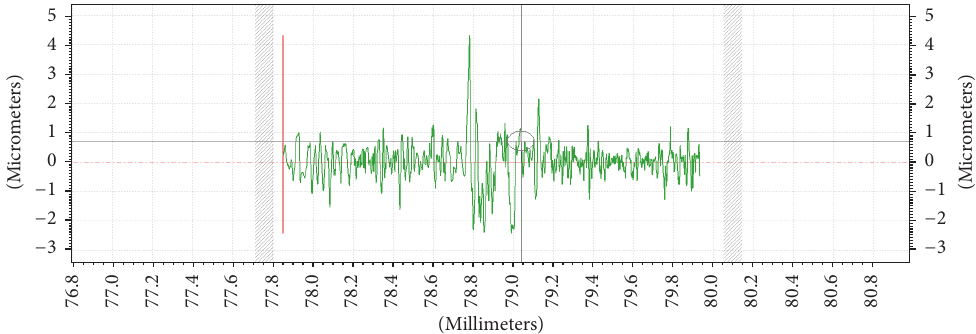
Figure 11: 2D roughness profile of Inconel 718 specimen (parameters: temperature: 45 ∘ C, concentration: 600g/L, and time: 40